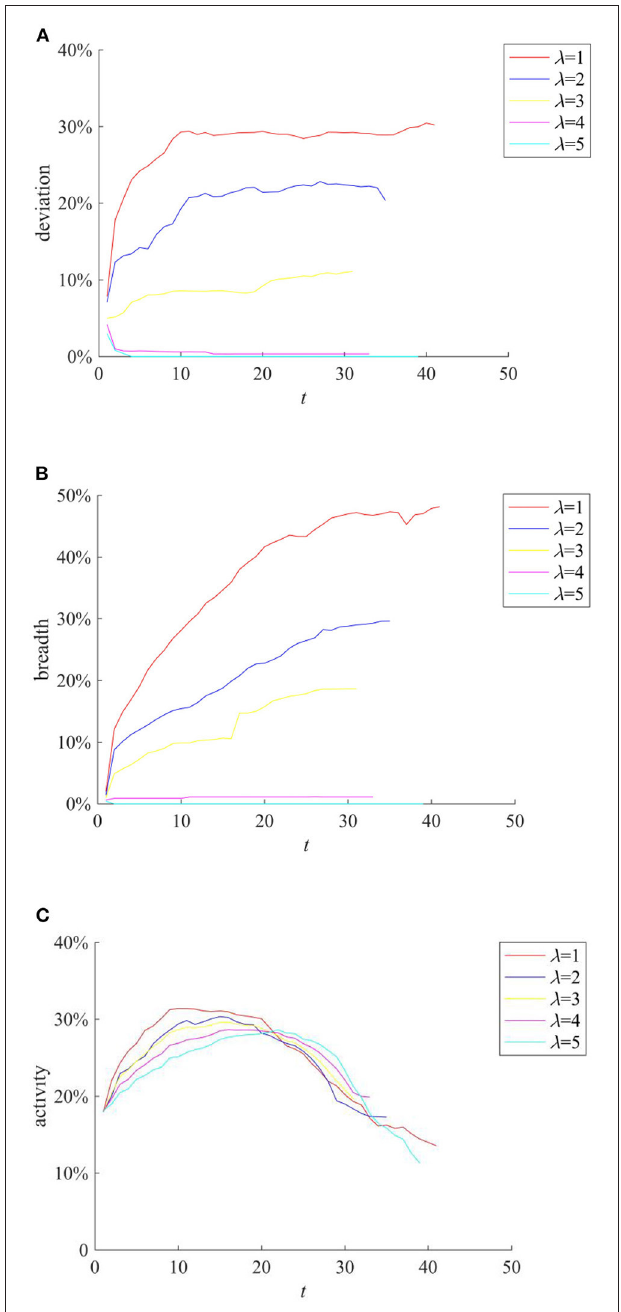
FIGURE 9 | The effects of different knowledge popularization strategies. (A) Entire network information content deviation. (B) Rumor diffusion range. (C) Network